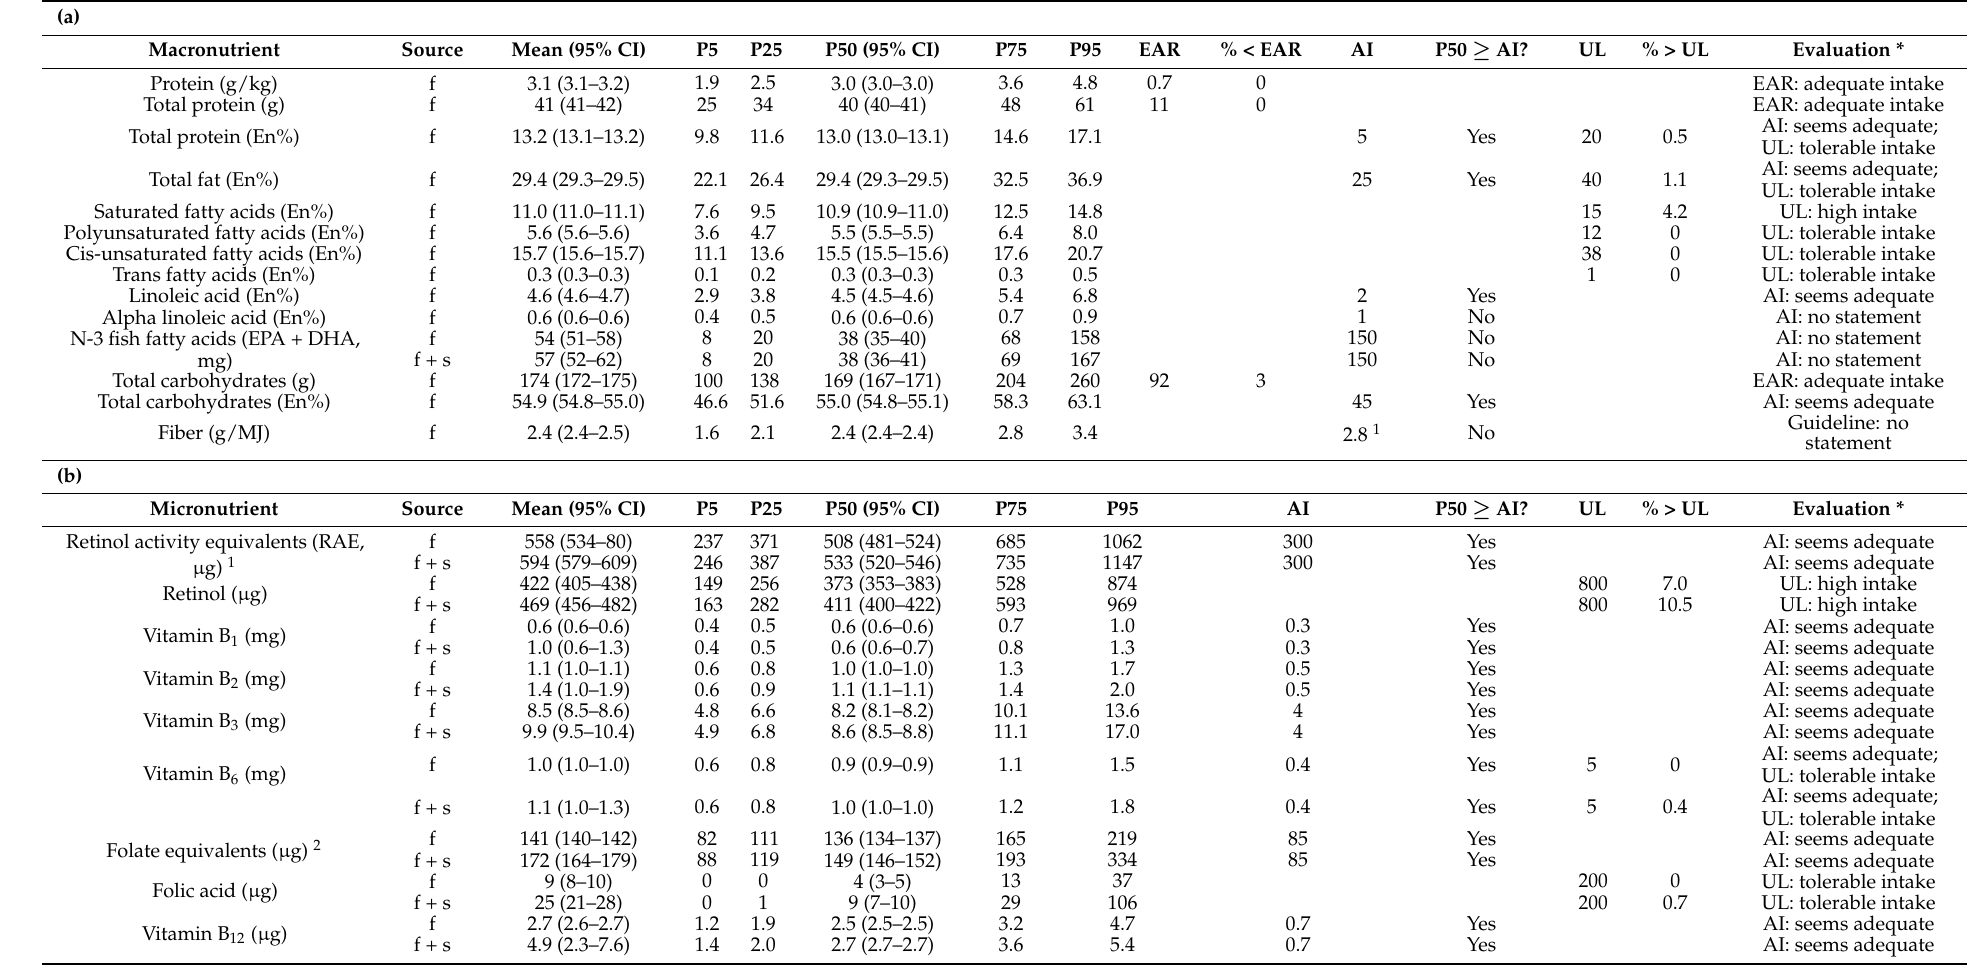
Table 2. ( a ) . The distribution of habitual macronutrient intake (per day) from food only (“f”) and, if relevant, from food and dietary supplements (“f + s”) by Dutch children aged one to three years (DNFCS 2012–2016, n = 672, weighted for demographic characteristics, season, and day of the week). ( b ) The distribution of habitual micronutrient intake (per day) from food only (“f”) and, if relevant, from food and dietary supplements (“f + s”) by Dutch children aged one to three years (DNFCS 2012–2016, n = 672, weighted for demographic characteristics, season, and day of the